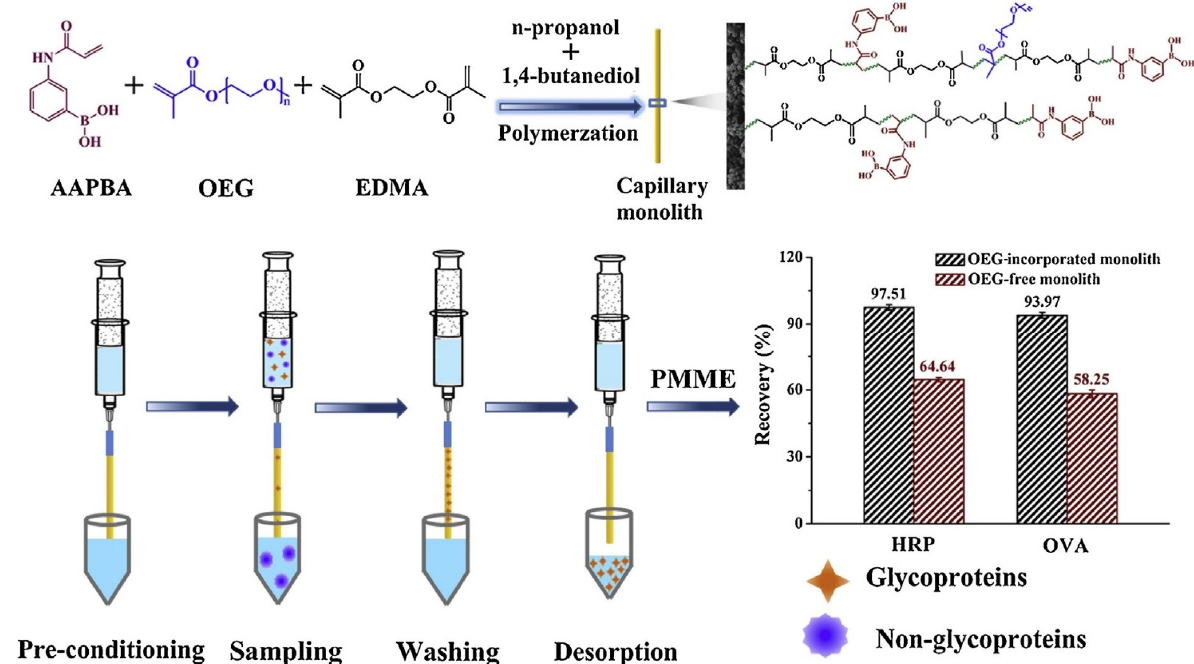
Figure 3. Schematic of synthesis and PMME analysis of HRP and OVA using poly(AAPBA-co-OEG- co-EDMA) monolithic column. Reprinted with permission from reference [78].